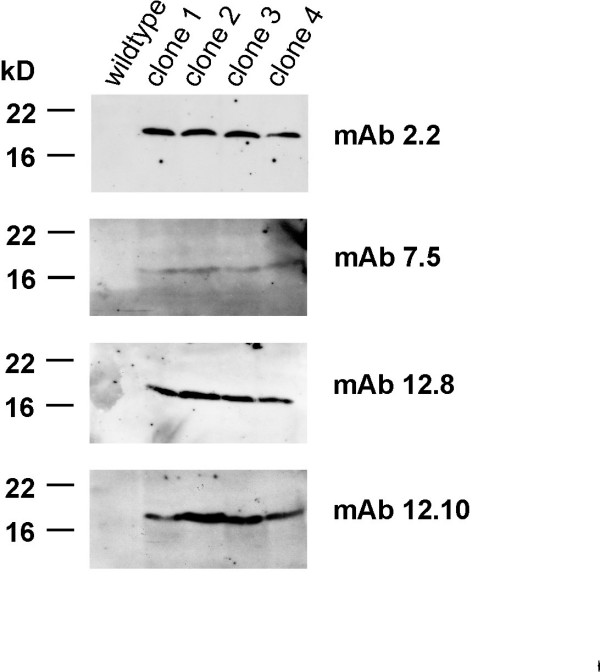
Expression of the 19 kDa C-terminus of MSP1 in T. thermophila. Aliquots (extract of 50,000 cells) of a non-transformed wildtype and cells of transformed clones (clones 1–4) that were transformed with pKOIX-MSP119 construct were separated on 15 % SDS-PAGE. The recombinant 19 kDa fragment of MSP1 could be detected in all clones (1–4) with four independent monoclonal antibodies (mAbs 2.2, 7.5, 12.8 and 12.10) all derived against the C-terminus of MSP1 of P. falciparum. No signal could be observed in the wildtype negative control. The monoclonal antibodies were kindly provided by Prof. J. McBride (Edinburgh, UK).